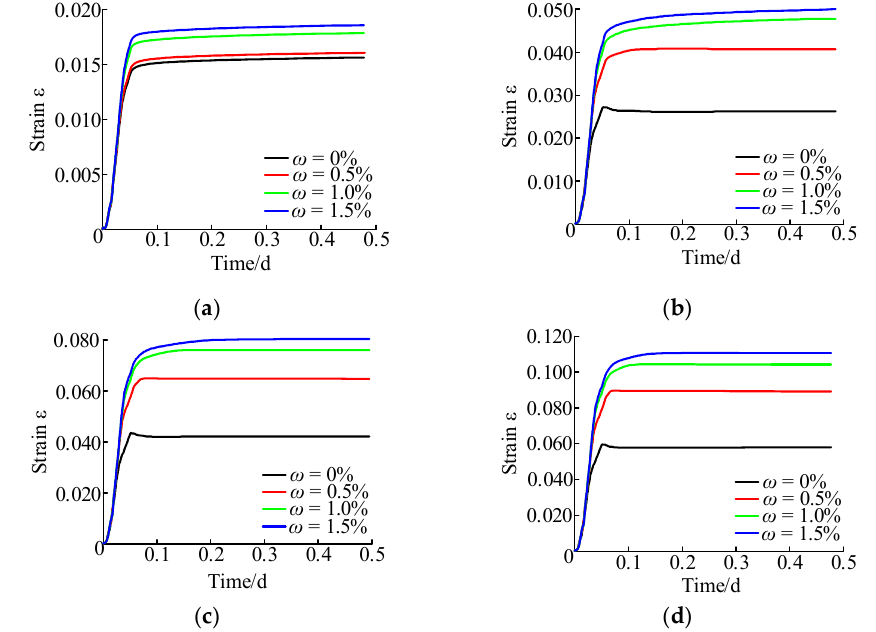
Figure 6. Strain-time curves of coal-rock combination under different moisture content: ( a ) Axial stress 5 MPa; ( b ) Axial stress 8 MPa; ( c ) Axial stress 11 MPa; ( d ) Axial stress 14 MPa.